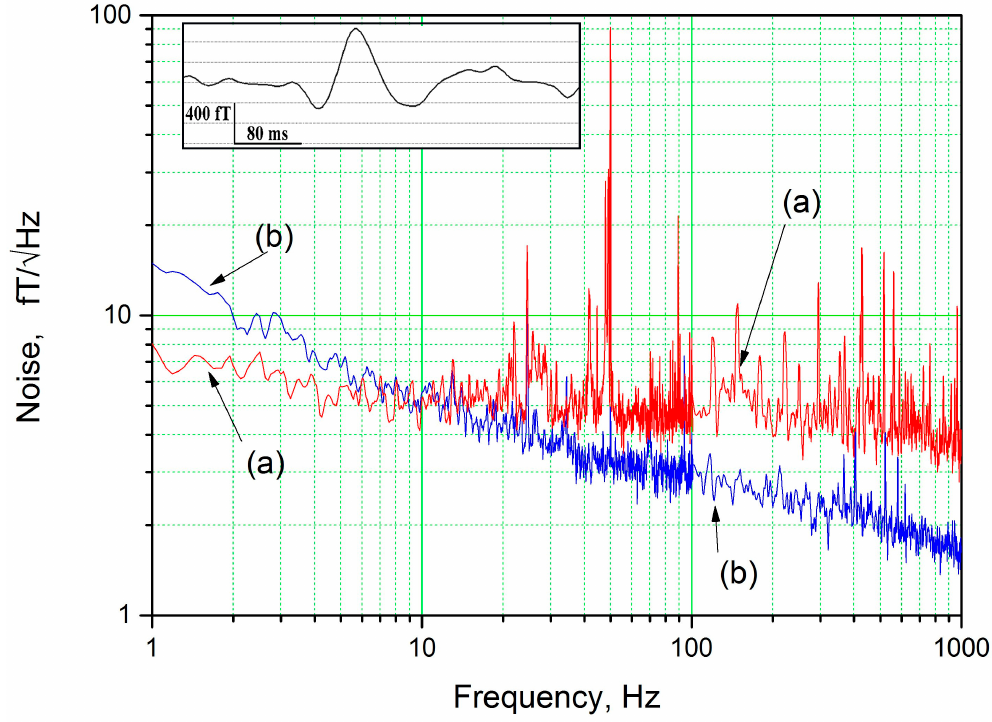
Figure 10. Noise spectra of a 20 mm high-T c DC SQUID magnetometer measured at 77 K in a magnetic shield: ( a ) without a ferromagnetic antenna and ( b ) with a ferromagnetic antenna. The inset shows a measurement of human magnetoencephalography performed using a high-T c DC SQUID magnetometer that has a sensitivity in the femto-Tesla range at low frequencies.